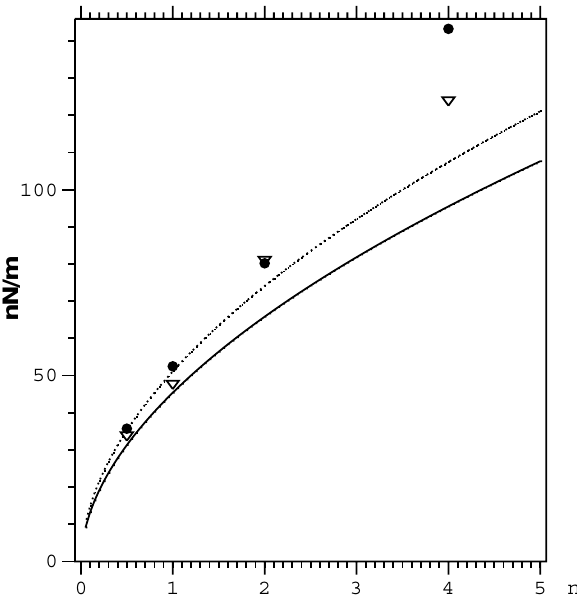
Fig. 7. Same as Fig. 6, but as function of solar wind electron den- sity, normalised to 7 . 3 × 10 6 m − 3 .